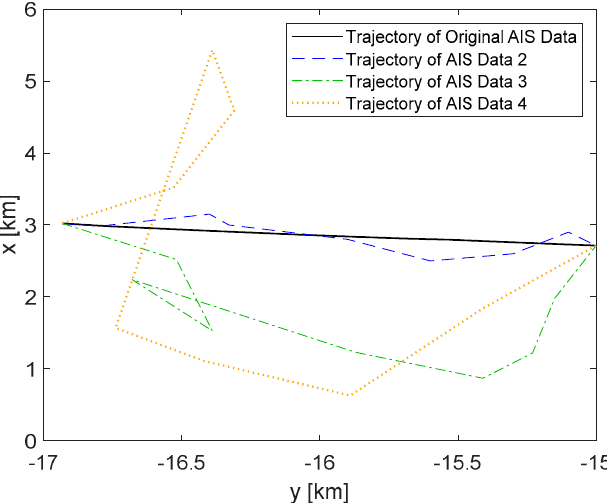
Figure 9. Trajectories of AIS data2 to AIS data 4.